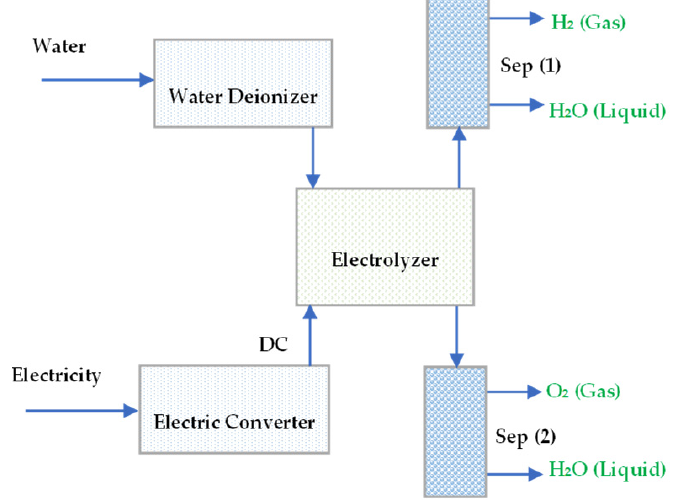
Figure 1. The electrolysis of water with supplied DC power.